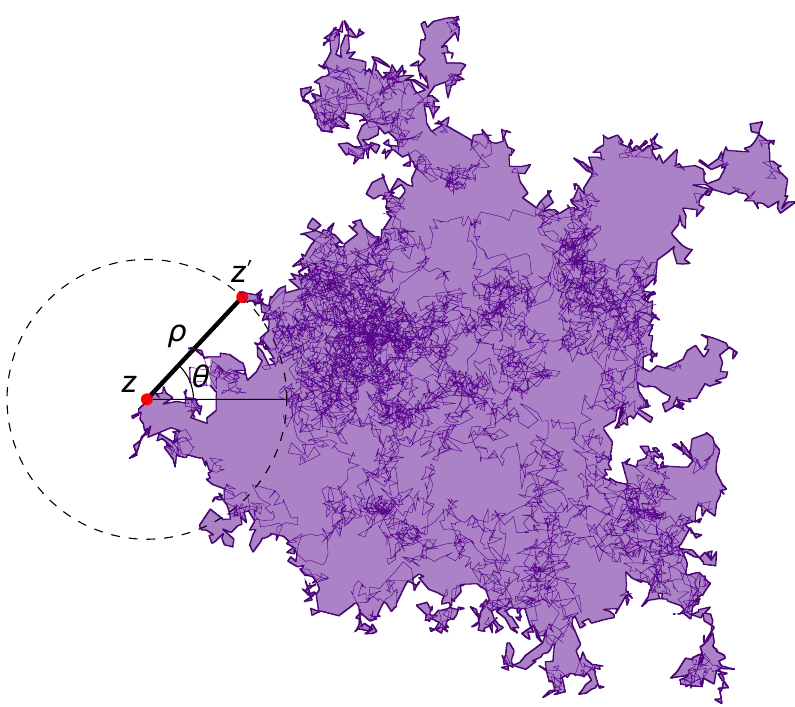
Figure 2 . Every loop whose outer boundary comes close to the point z and intersects the dashed circle somewhere contributes to T ( z ) in (2.4). The red points represent the insertion points of the edge-counting operators E at z and z 0 = z + ρe iθ